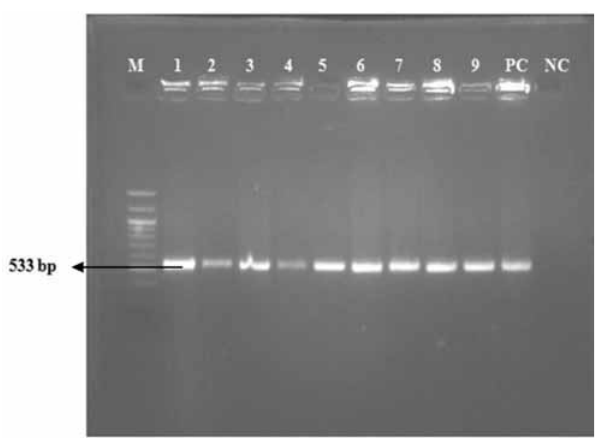
mecA Figure-5: Amplification of Figure-4: Amplification of gene of MRSA. M: 100bp ladder, 1-9: MRSA test samples, PC: Positive Negative control. control, NC: Negative control. S. aureus respectively